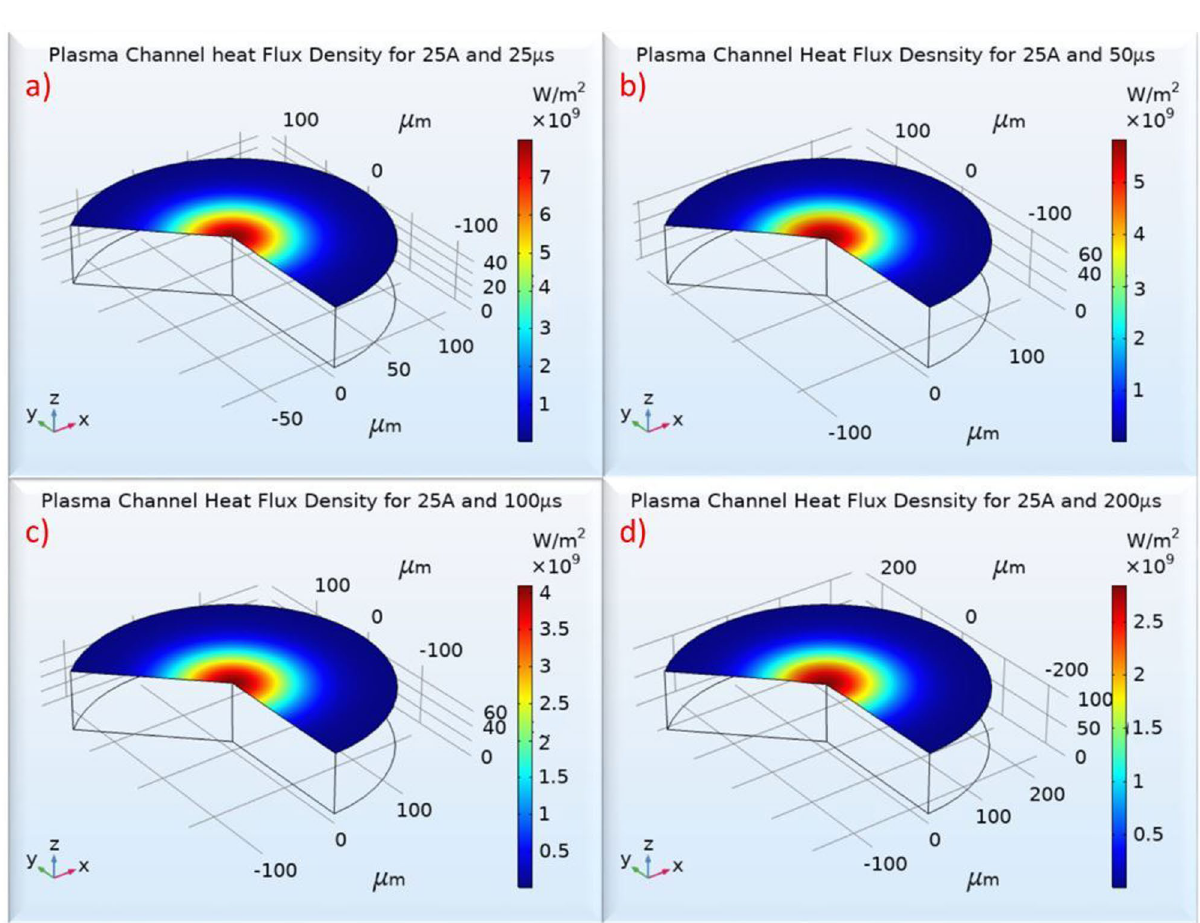
Figure 17. Electrode’s Plasma Channel’s Heat Flux for 25A and ( a ) 25 μs, ( b ) 50 μs, ( c ) 100 μs and ( d ) 200